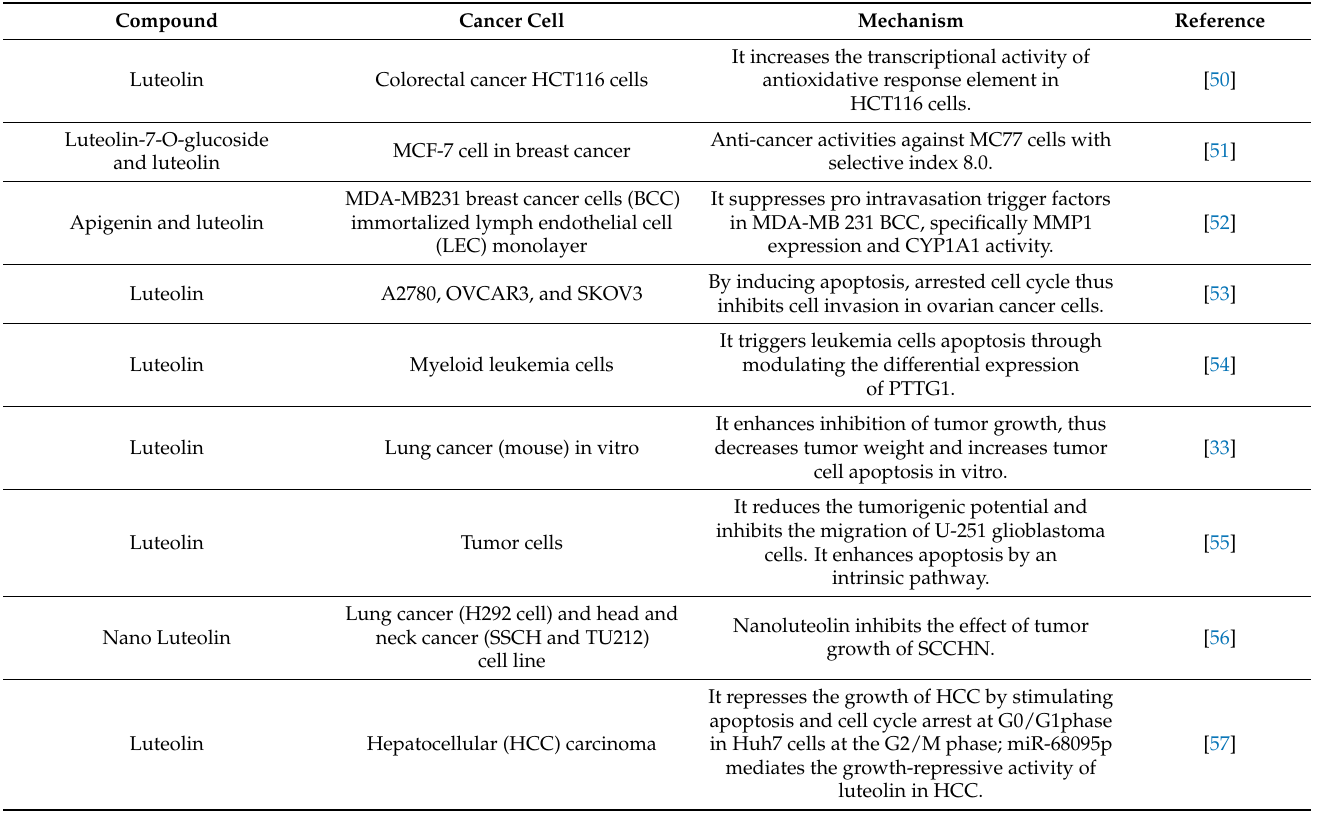
Figure 4. The anti-cancer effect of luteolin compounds against different cancer cells was sketched. The anti-cancer activity of the compound and its mechanism for preventing cancer cells involving different mechanisms. Table 1. The mechanistic action of luteolin and its types against various types of cancer